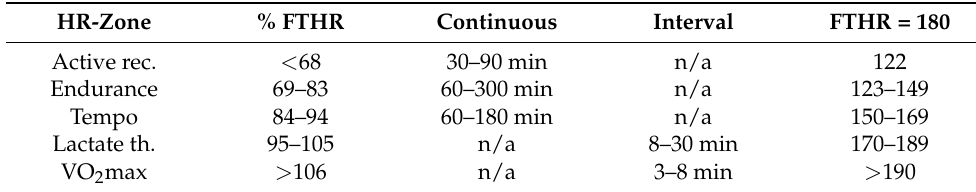
Table 1. HR-based training